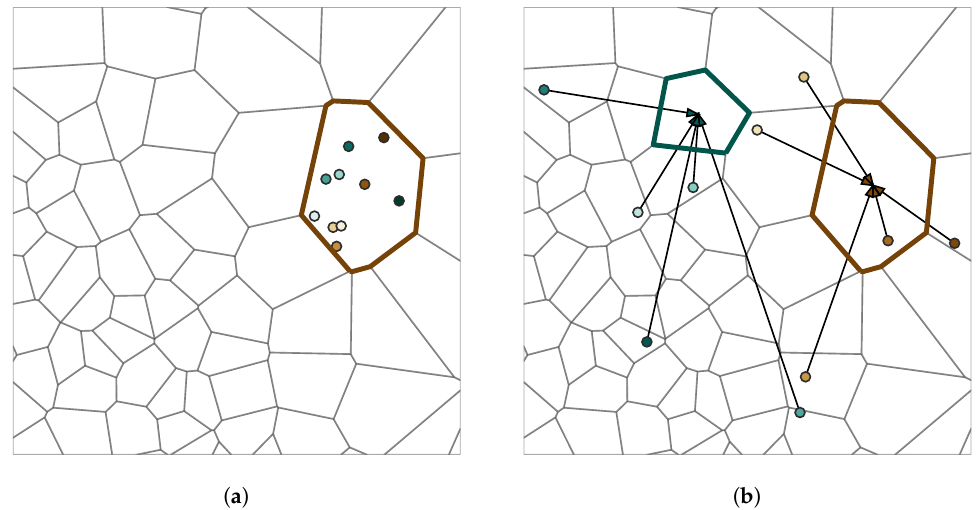
Figure 8. Visualizing the difference between the cell-based ( a ) and the inhabitant-based ( b ) ap- proaches. The former considers subscribers present in a given cell wherever they live. The latter aggregates the activity of the inhabitants to the home cell, regardless of where the activity